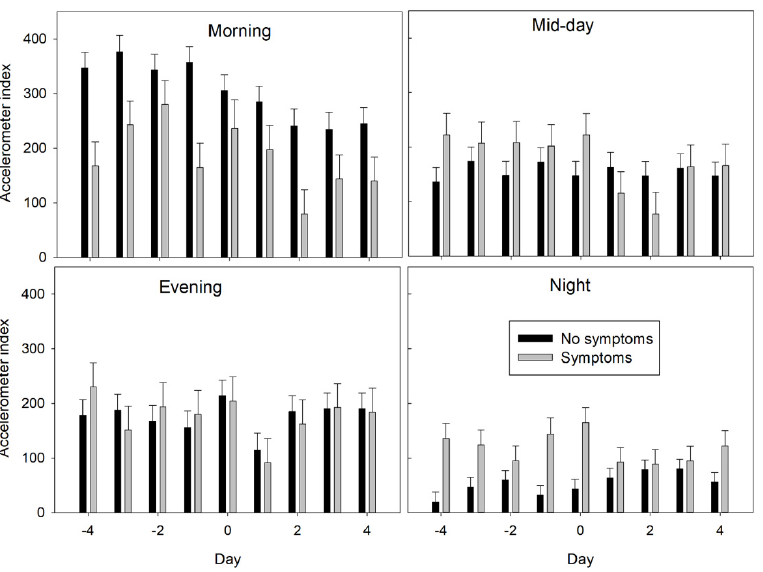
Figure 3. HerdDogg accelerometer index values for ewes demonstrating symptoms (e.g., reduced feed intake and difficulty walking) during the morning (0800 to 1100 h), midday (1100 to 1700 h), evening (1700 to 2000 h), and night (2000 to 0800 h). Sheep were fed at 0800 h. Ten ewes were monitored for 4 days ( − 4 to − 1) prior to receiving an unexpected ration change of moldy corn silage on days 0 and 1. Moldy feed was removed in the evening of day 1 when symptoms were first observed. Error bars represent standard errors.